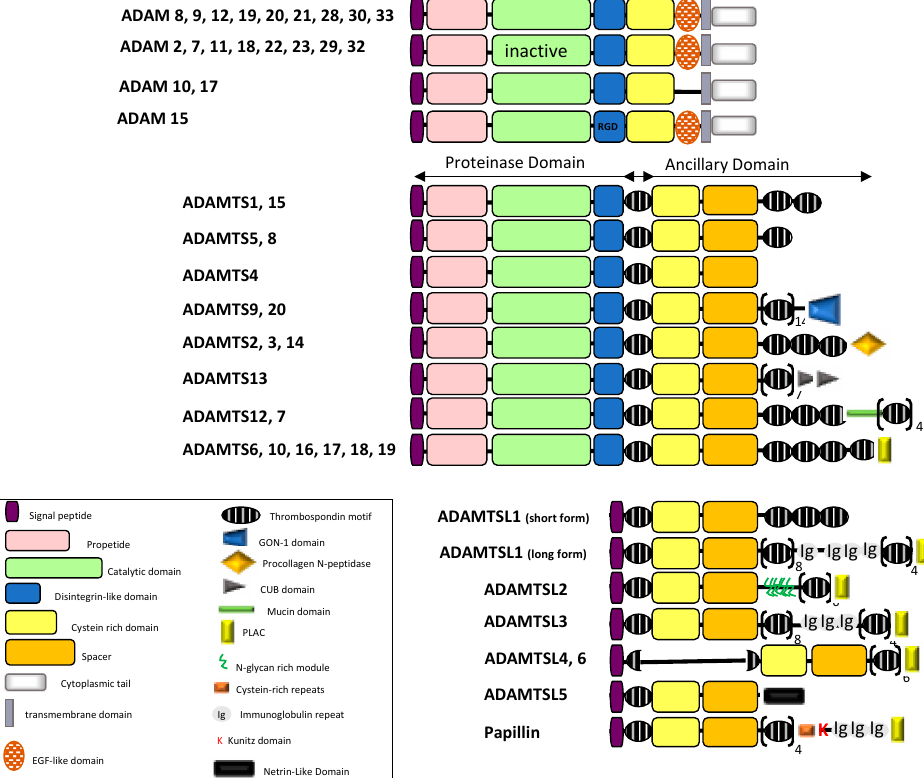
Figure 1. Schematic diagram illustrating the domain organization of the ADAM/TS-TSL family members (adapted from [2,3,5]).